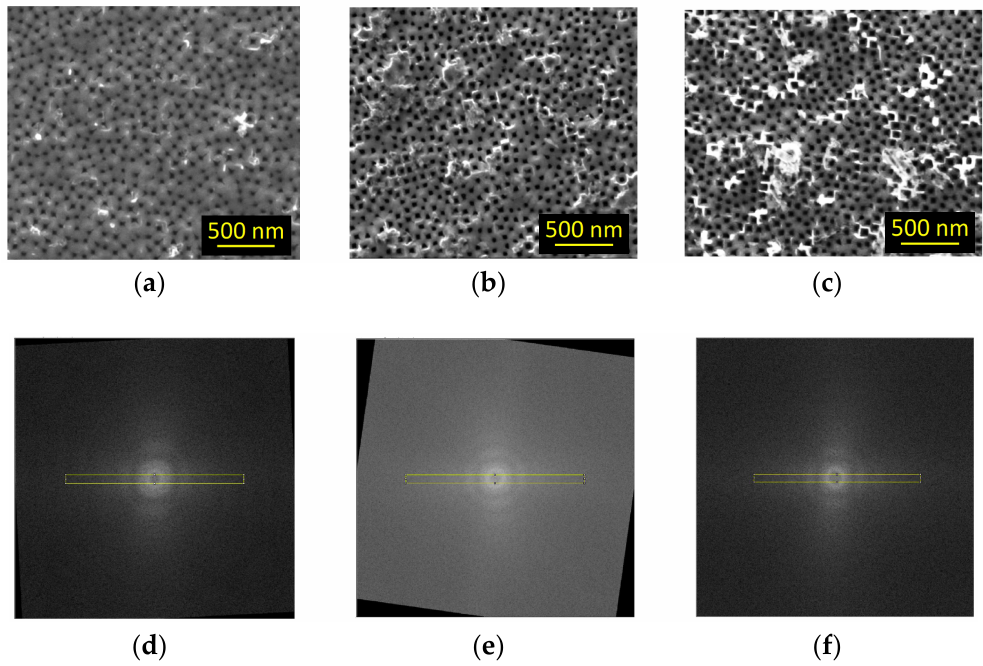
Figure 6. SEM images ( a – c ) of three PSi samples prepared with identical formation parameters after three different ENL processes. From left to right, the formation current of SDL-2 increases, while all other parameters have been kept constant. In particular, SDL-1 layers are nominally identical in all samples. On the bottom row ( d – f ) are shown the fast Fourier transform (FFT) of the SEM images ( a – c ), in the same order. The FFT has been calculated on squared areas of the respective SEM images. The yellow rectangles on the FFT images, identical for all samples, are the area over which the profiles of Figure 7 are calculated. If needed, the FFT images have been rotated to align the rectangle and the order-related fringes appearing on the FFT images, so to ensure that all images are analyzed coherently.